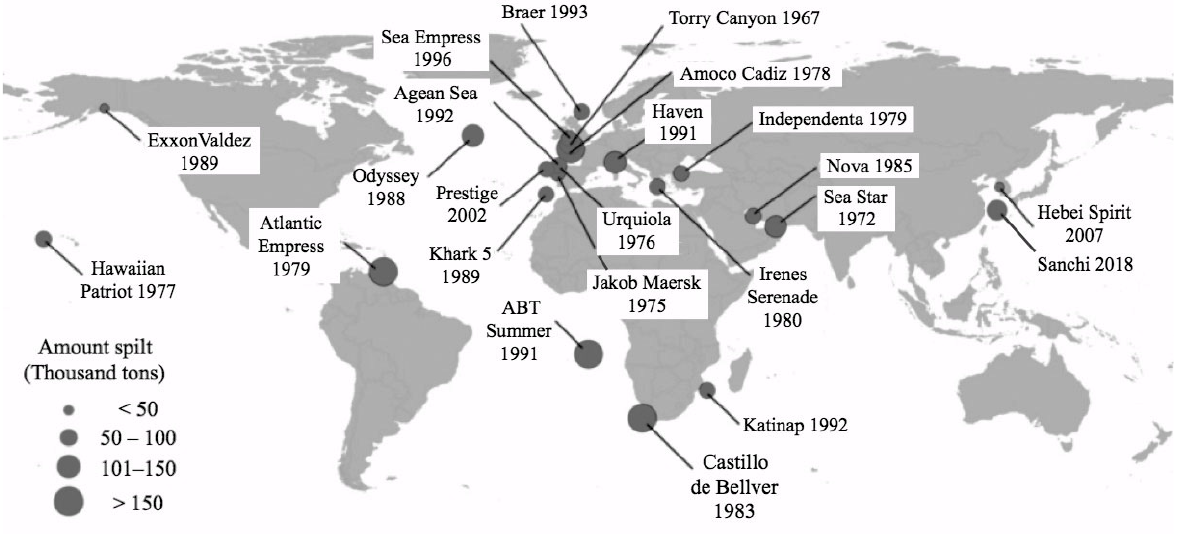
Figure 14. Major oil spills by tankers from 1967 to 2021. (Courtesy of ITOPF 2021 [96]). One of the latest spills, among others, occurred when the anchored Hebei Spirit oil tanker collided with a crane vessel off the east coast of Korea on the 7 December 2007 [97]. Figure 15 shows the ENVISAR-ASAR C-band image acquired four days after the collision. In the figure, the dark areas around the tanker (white circle) correspond to the spilled oil. The other dark areas in the top-left and those near the coasts are considered as wind-sheltered areas. Similar dark images are observed, for example, by cold up-welling water, biogenic slicks, rain cells, and algae. These images are called “look-alikes” and the classification of oil spills and look-alikes is one of the main research subjects, as well as the classification of different types of oil such as crude oil, plant oil, emulsion (mixture of oil and water), and natural seep oil [98]. Note that the long white linear images are associated with the interaction between the currents and bottom topography, as will be discussed